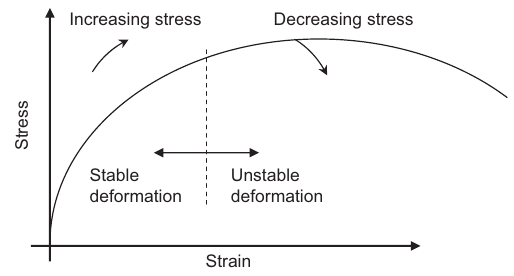
Figure 10 Stable and unstable plastic behavior of